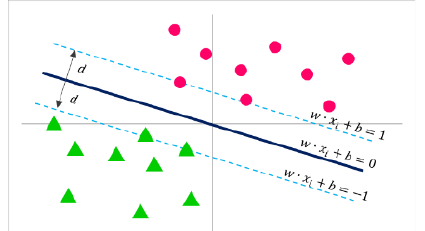
Figure 5: Illustration of the Linear SVM algorithm Figure 5 visualizes the SVM. For each vector, x i , the hyperplane is defined (Berwick, 2011): Table 6. Principal component analysis results of the